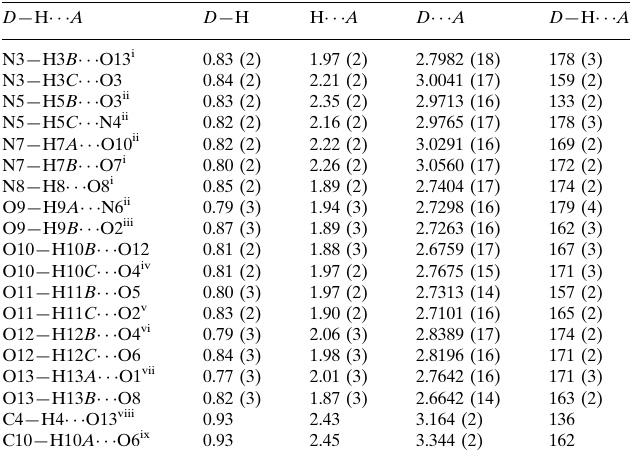
Hydrogen-bond geometry (A˚ , (cid:3)